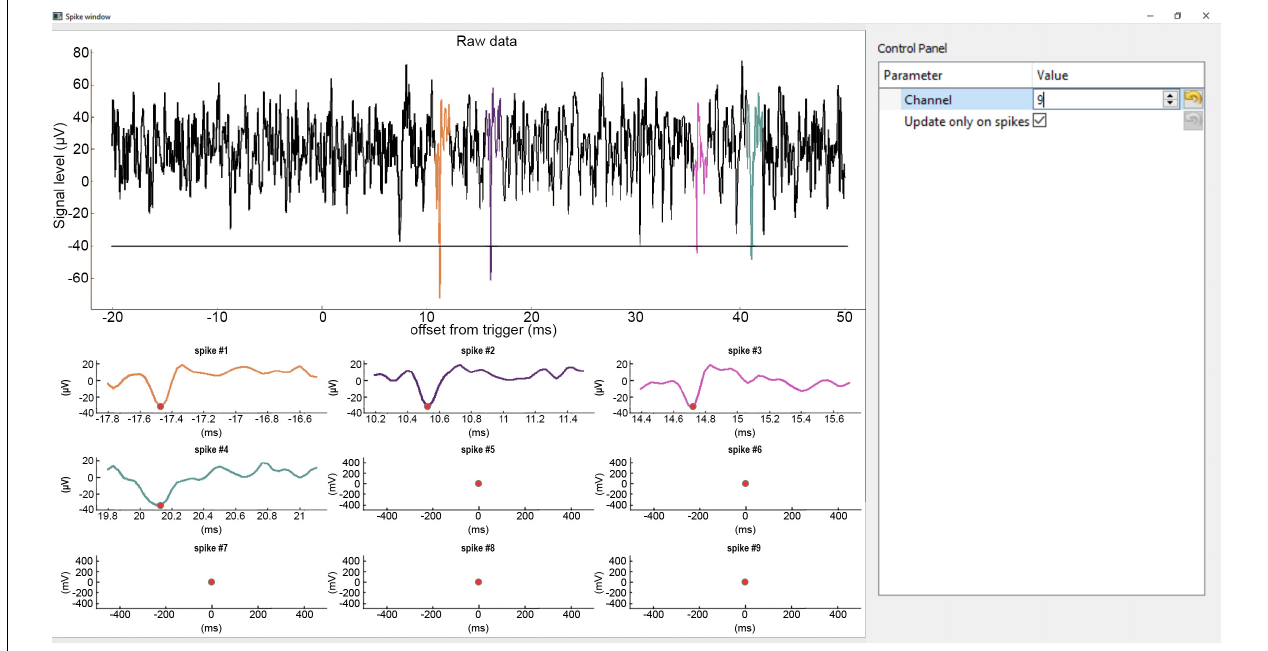
FIGURE 3 | Spike window. Top, continuous raw input data from the selected channel with spikes detected in restricted temporal windows (ROI) aligned to the trigger event (TTLs). The detected spikes are superimposed in color. Horizontal line shows the spike detection threshold. Bottom, zoomed-in windows of the detected spikes. The spike plots display a short segment of data before and after the peak value (red dot) of the spikes ( − 0.3 ms to +1 ms by default). The same color code is used for the spikes across the